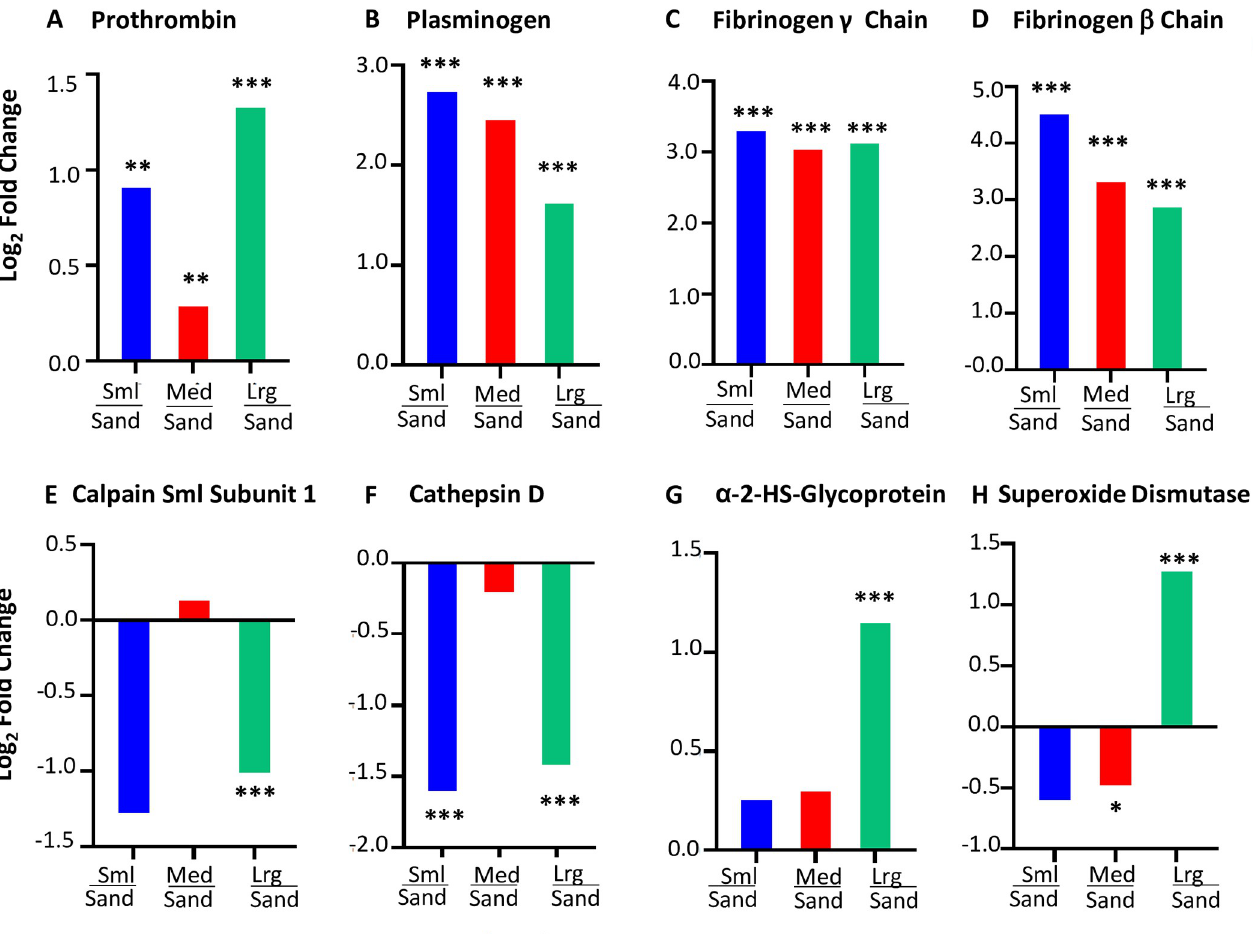
Fig 6. Changes in diverse proteins detected displaying log-scale fold-changes. The bar graphics all display a ratio (stone vs sand), or more specifically: log2-fold changes comparing either ‘small vs sand’, the comparison ‘medium vs sand’, and the comparison ‘large vs sand’ for all shown proteins. (A) Levels of prothrombin increased across all stone sizes (compared to sand), but most drastically when comparing large stones vs sand. (B) Plasminogen (PLG) shows the largest increase in small stones vs sand, and continues to show upregulation in medium/sand and large/sand. (C-D) Fibrinogen gamma-chain (FGG) shows large increases across all stone sizes when compared to sand, and beta chain (FGB) displays the largest increase in small stones vs sand, and continues to show upregulation in medium/sand and large/sand. (E-F) Lower levels of proteases Calpain 4 and Cathepsin D are found in large stones than in sand. (G) Protease inhibitor AHSG was increased in large stones vs sand. (H) SOD1 is most drastically changed in the large stones, compared to sand. ( � = p < 0.05; ��� = p <